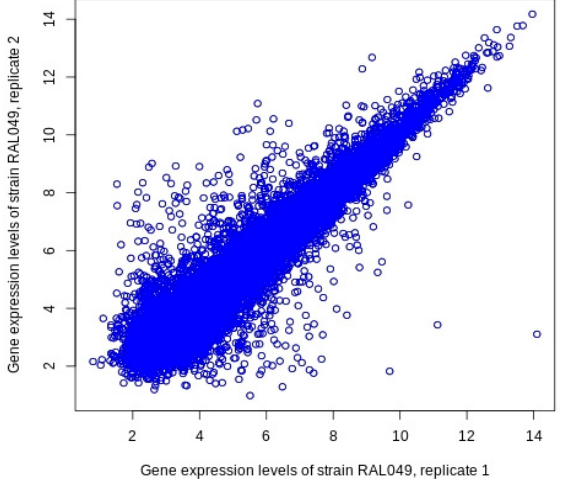
Figure 1. Inconsistent gene expression levels between the two replicates of strain Ral049.